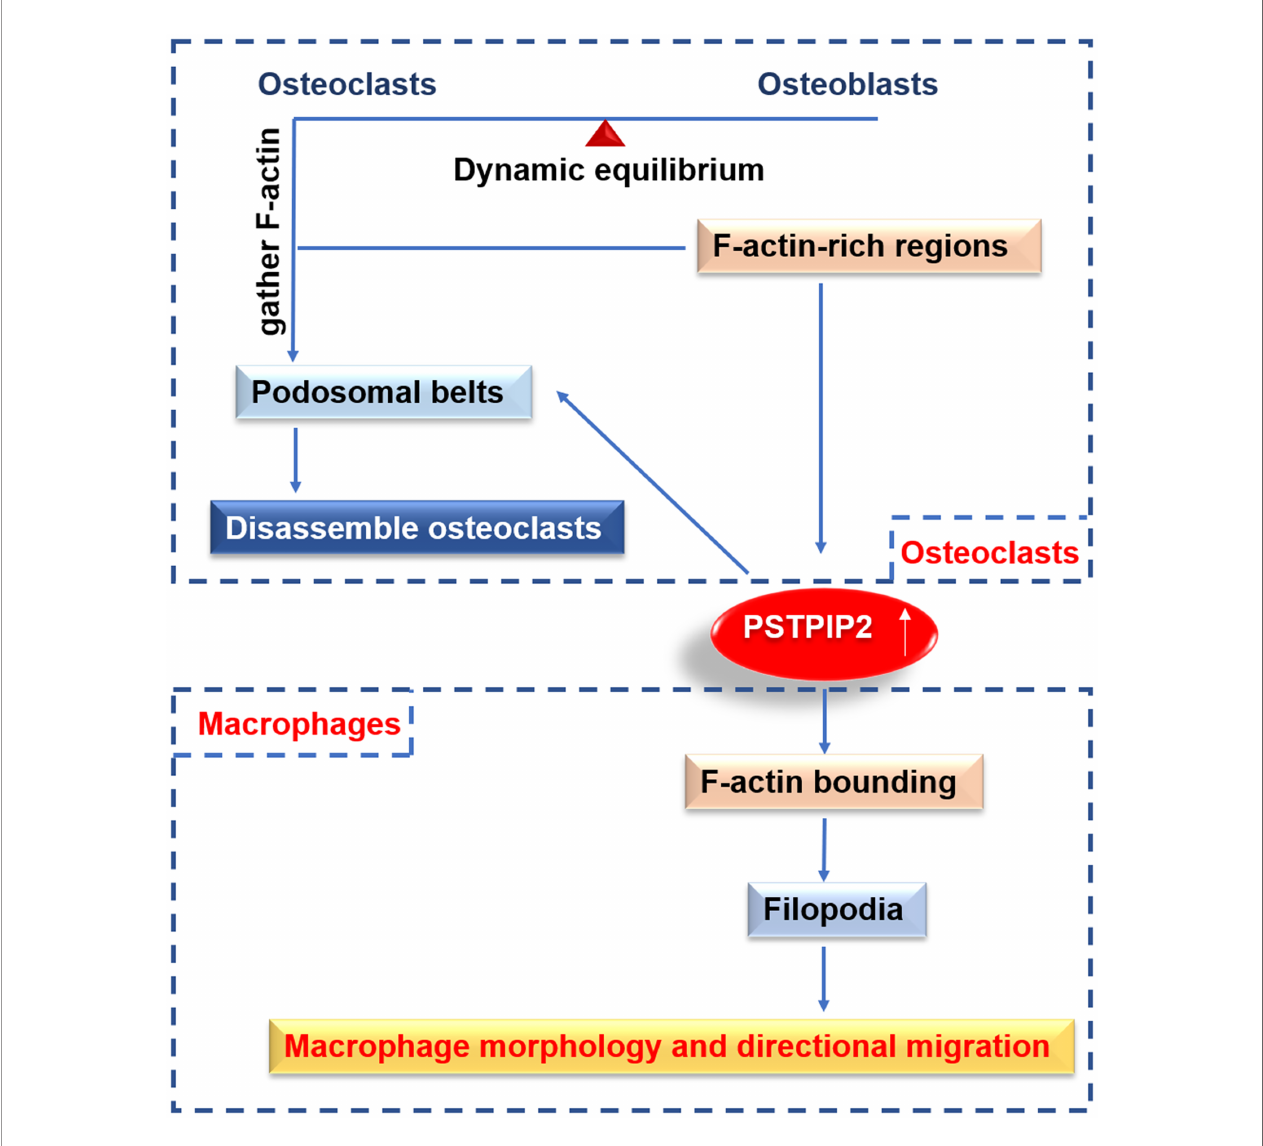
FIGURE 2 | The function of PSTPIP2 in various cells. In macrophages, PSTPIP2 participate in F-actin bundling, promote the formation of fi lopodia, and then control the morphology and directional migration of macrophages. In osteoclast, PSTPIP2 is highly expressed in F-actin-rich area, and regulate the formation of podosomal belts to promote the decomposition of osteoclast, which plays an important role in the belt dynamic balance of osteoclasts and